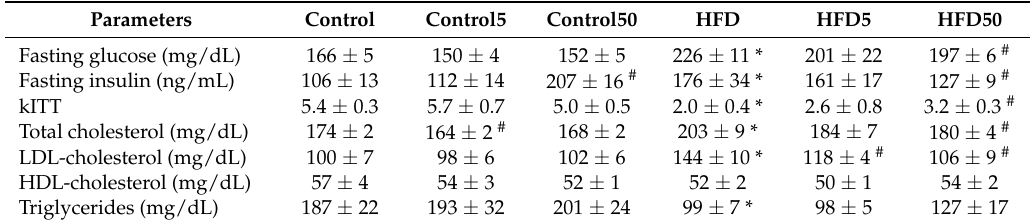
Table 3. Serum parameters and kITT of control mice, control mice treated with AERM 5 mg·kg − 1 (Control5) or 50 mg·kg − 1 (Control50), obese mice (HFD) and obese mice treated with AERM 5 mg·kg − 1 (HFD5) or 50 mg·kg − 1 (HFD50).